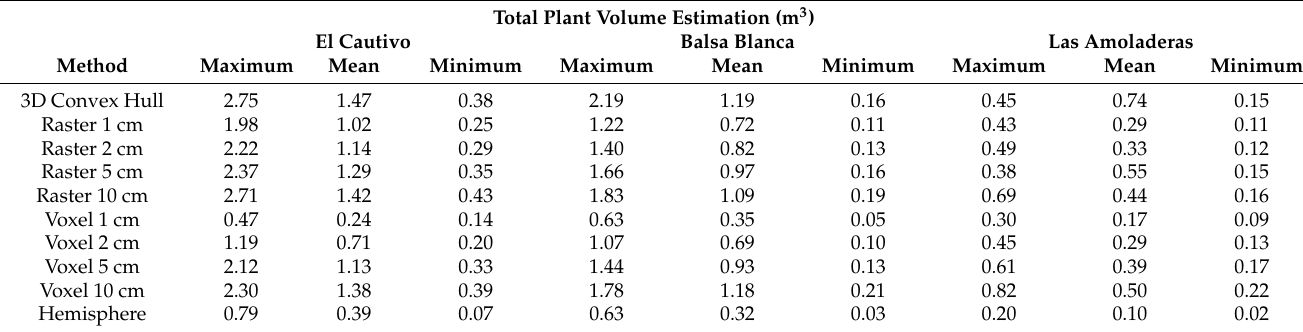
Table 2. Maximum, mean, and minimum plant volume values (m 3 ) obtained by the hemisphere model based on field measure- ments and the different TLS based approaches: 3D convex hull, raster, and voxel methods (with varying spatial